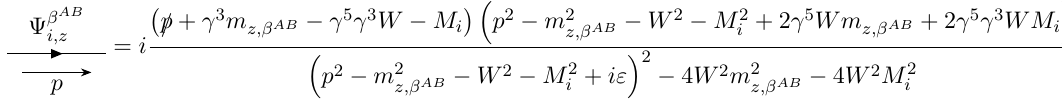
Figure 1. The propagator of the non-Cartan adjoint fermions, assembled into the four-component spinor (A.7), in the background of nontrivial gauge, h ~A 3 i , included in m U(1) , W , holonomies. When W = 0 , the propagator, shown on figure 6, drastically